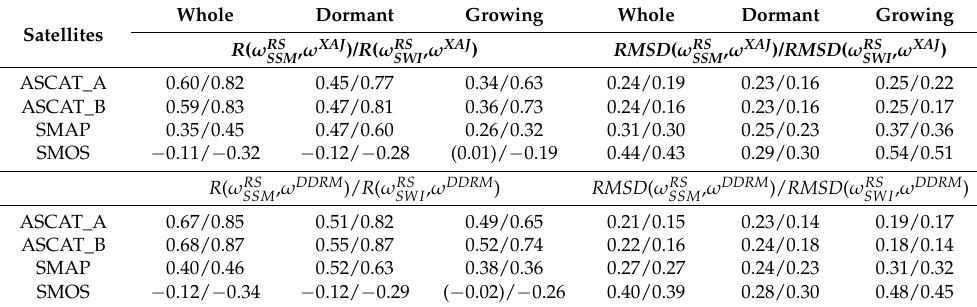
Table 4. Correlation values R and the root mean square difference RMSD between remotely sensed products ( ω RS and ω RS ) and model-simulated soil moisture values from XAJ ( ω XAJ ) and DDRM ( ω DDRM ) for different periods of 2010–2016 (the whole period, the dormant seasons and the growing seasons). R values are shown in brackets when p > 0.05.